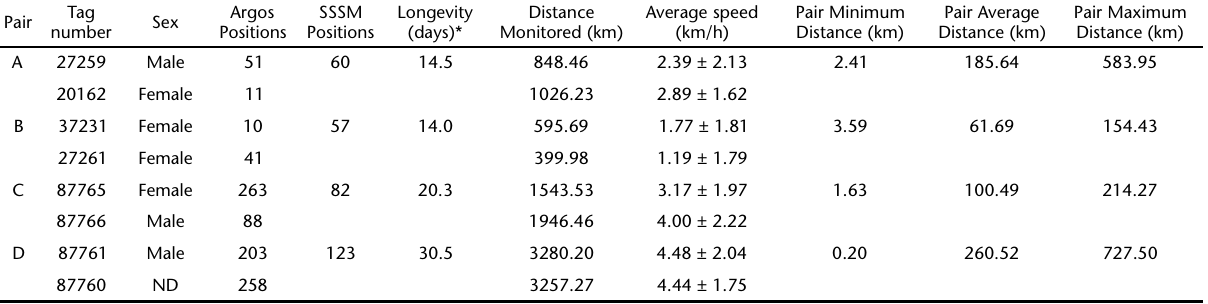
Table II. Satellite-monitored pairs of tagged humpback whales on the Brazilian breeding grounds between 2003 and 2008. (ND) Not determined. Tag Argos SSSM Longevity Distance Average speed Pair Minimum Pair Sex number Positions Positions (days)* Monitored (km) (km/h) Distance (km) A